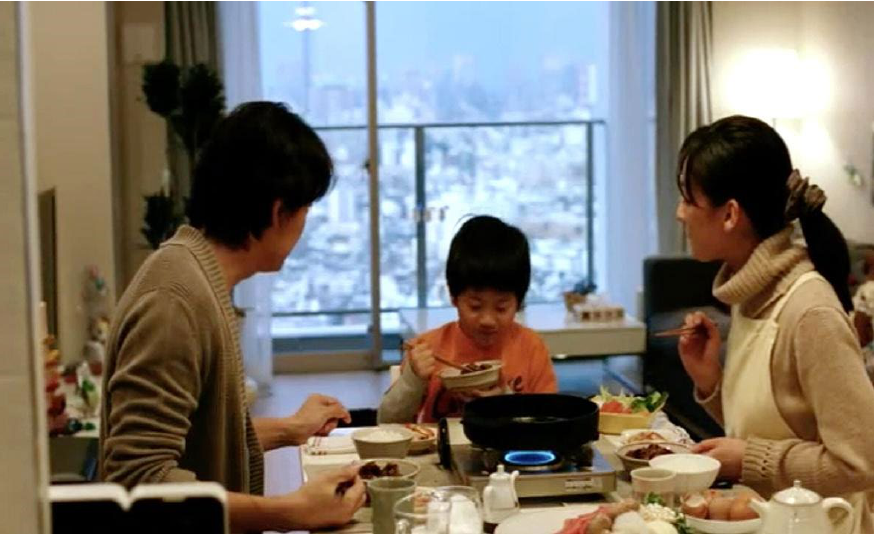
Figure 18 The architect's family lives in a high-rise condominium in the middle of Tokyo as if they look things down from the